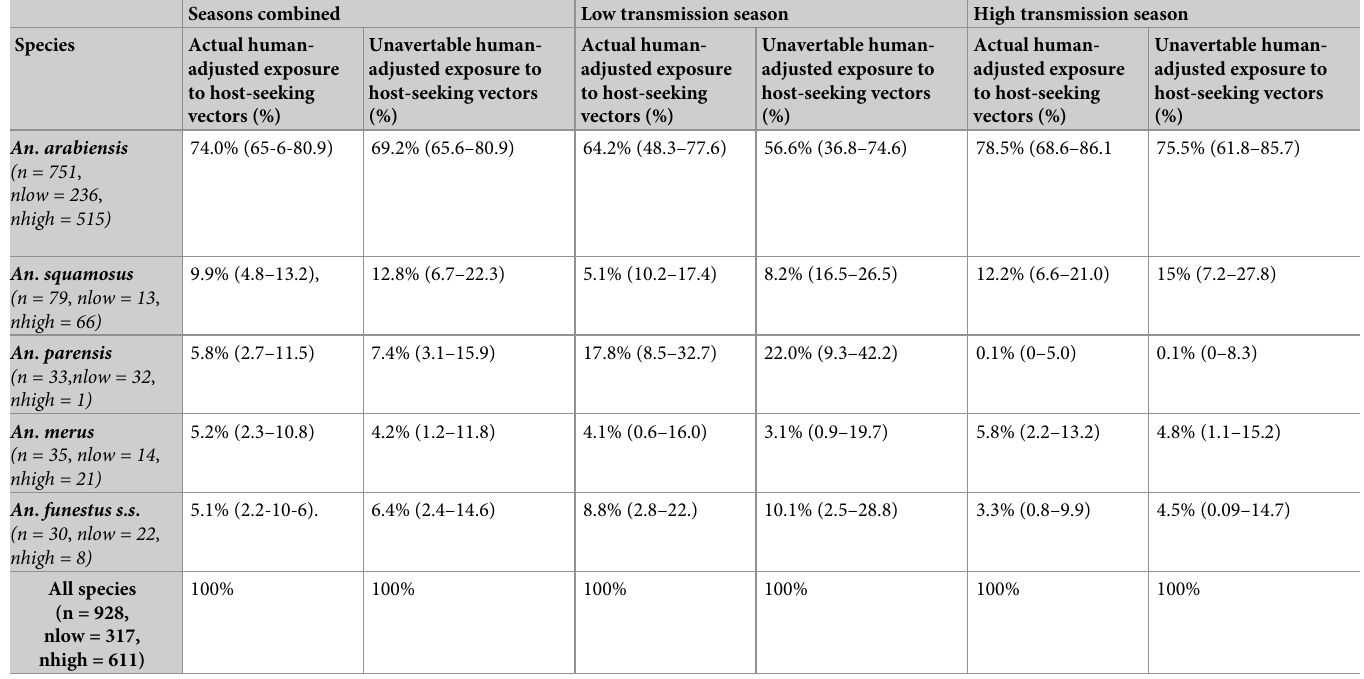
Table 2. The contribution of different vector species to the exposure to host-seeking vectors that Magude residents experienced. ‘Residual human-adjusted exposure to host-seeking vectors’ shows the percentage of host-seeking mosquitoes of each vector species that residents were exposed to at the observed levels of bednet use. ‘Unaver- table residual human-adjusted exposure to host-seeking vectors’ shows the percentage of host-seeking mosquitoes from each vector species that residents would have been exposed to if they all would have used a net when in